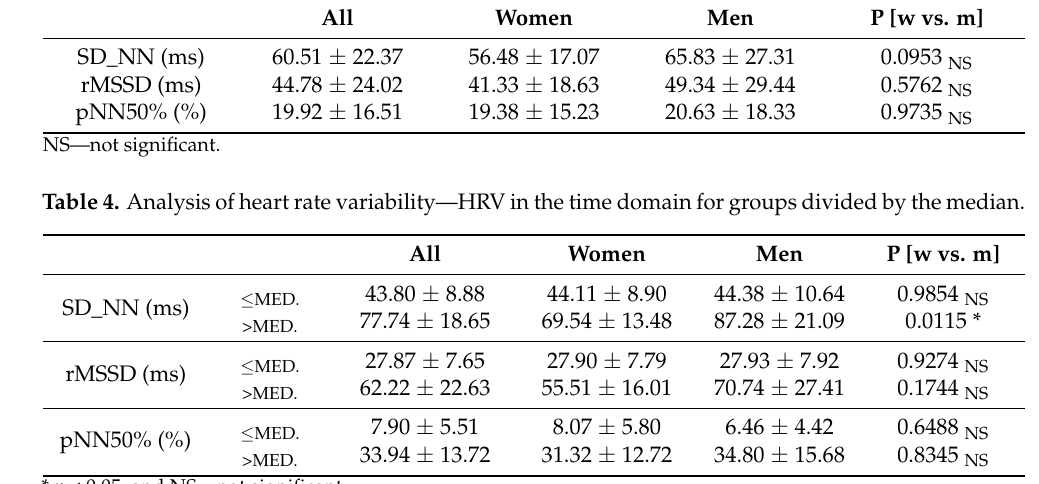
Table 3. Analysis of heart rate variability—HRV in the time domain. All